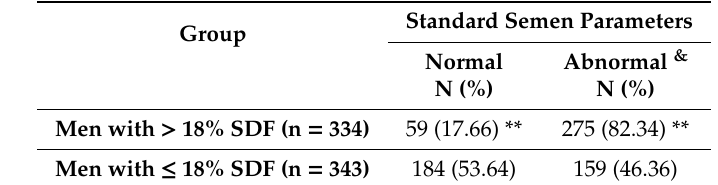
Table 2. Prevalence of normal and abnormal standard semen parameters in men with > 18% SDF and ≤ 18% SDF.